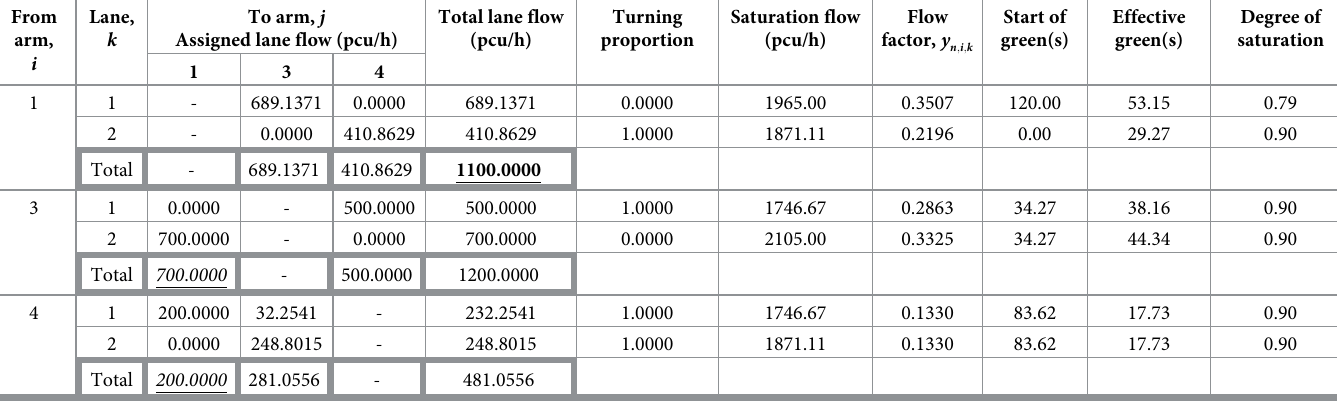
= z ¼ W = z ¼ 32 : 9 s (maximized), and z ¼ 1 = 120 : 0 . o ¼ 2 ; d ¼ 4 ; h o ; d ¼ 1 o ¼ 4 ; d ¼ 2 ; h o ; d ¼ 1